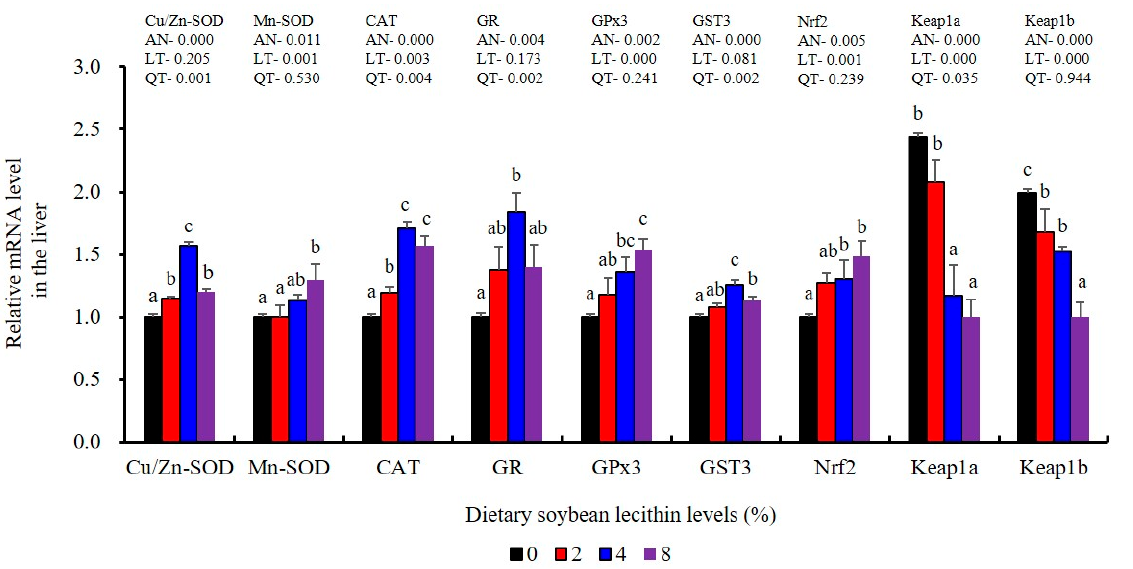
Figure 3. Effect of dietary soybean lecithin on expression levels of antioxidant-related genes in the liver of juvenile largemouth bass. Bars with different letters indicate significant differences ( p < 0.05), while that with the same letter or no letter superscripts indicate no significant differences ( p > 0.05), AN: ANOVA, LT: linear trend, QT: quadratic trend.